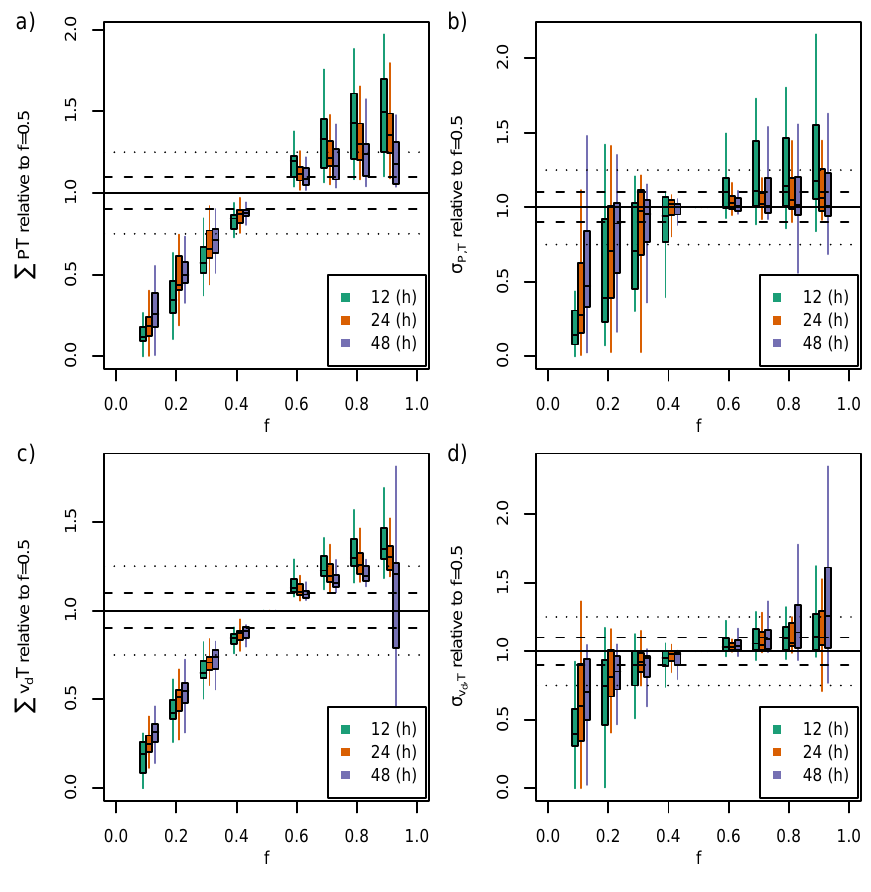
Fig. 6. Boxplots of catchment area parameters for 34 sites as derived for different total residence time thresholds f and 12, 24 and 48h catchment areas; (a) population sum P P T , (b) population variability σ P,T , (c) deposition sum P v d T and (d) deposition variability σ v